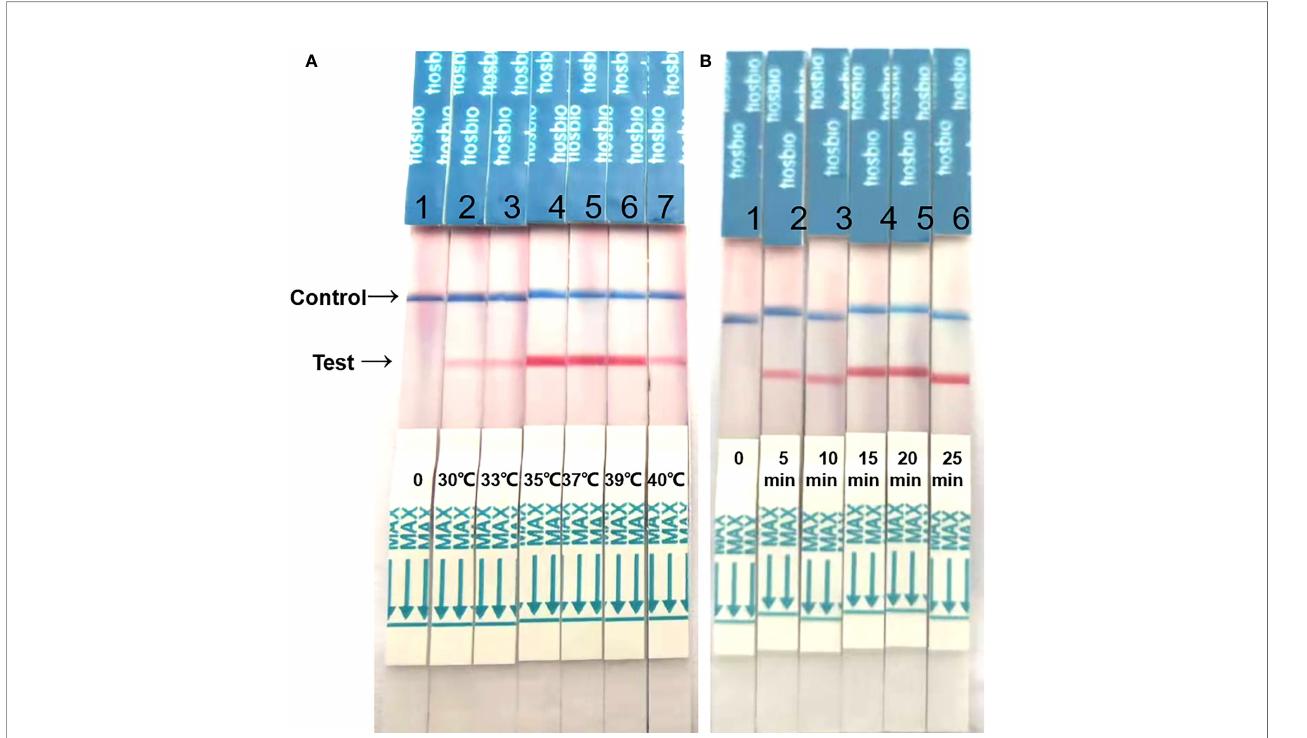
FIGURE 2 | Optimization of reaction temperature and time. (A) The RAA-LFD works effectively in a broad range of constant reaction temperatures. (B) After 20 min of isothermal ampli fi cation reaction, the test line is visible on the test strip. Including the incubation of 5 min the whole assay time of the RAA-LFD is less than 20